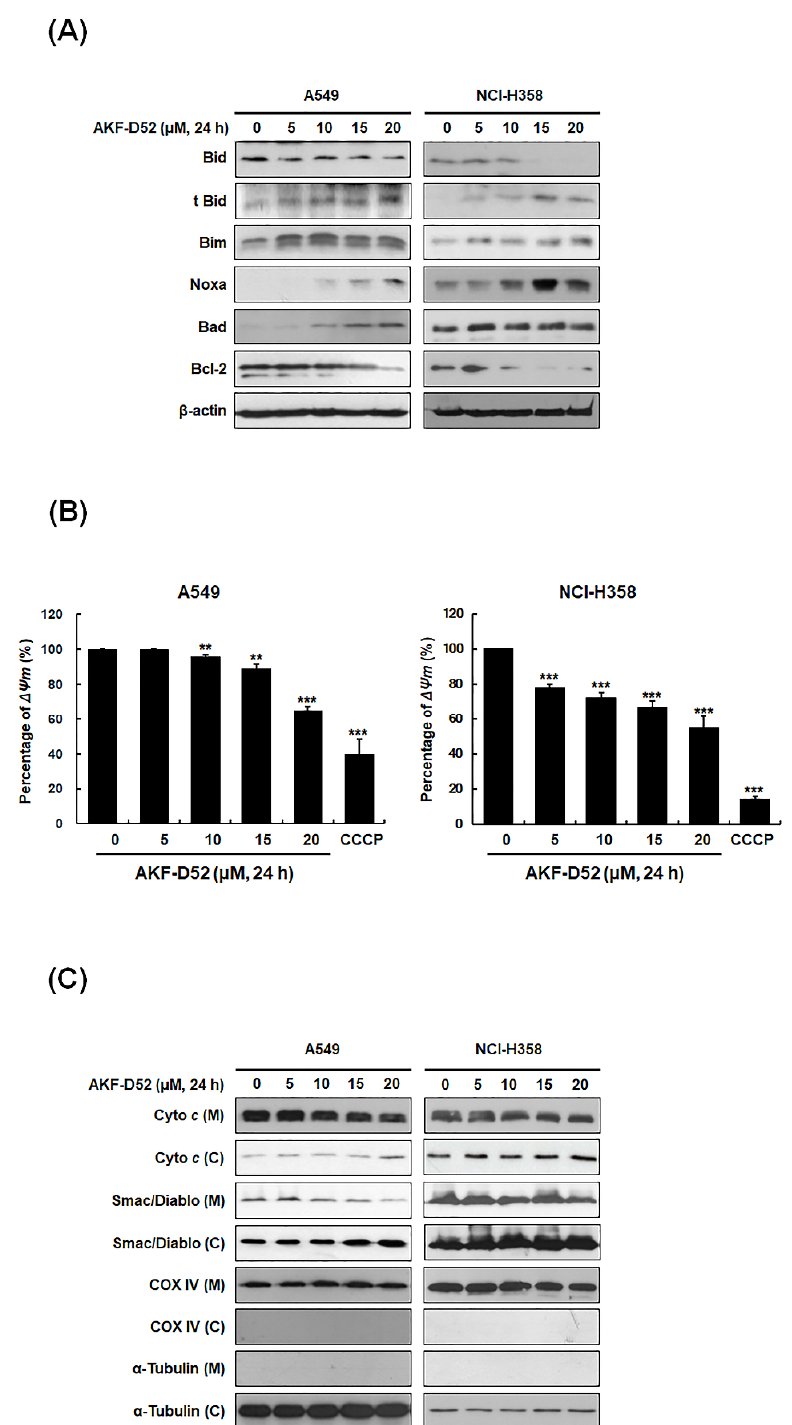
Figure 3. The effects of AKF-D52 on activation of the intrinsic pathway in NSCLC cells. Cells were